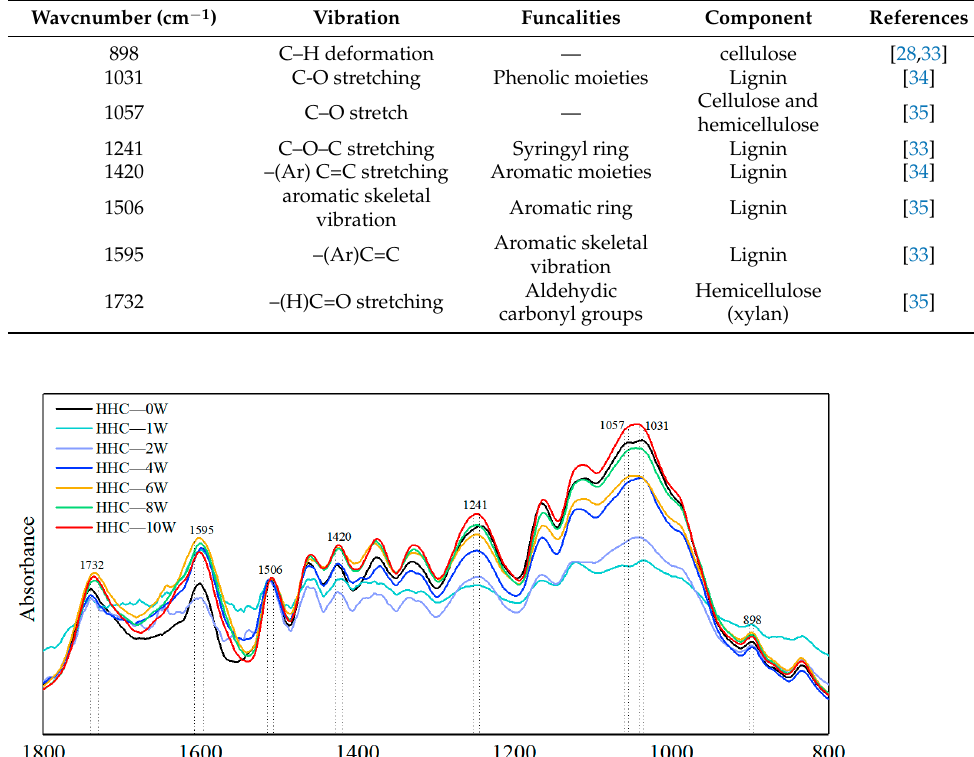
Table 5. Assignment of significant functionalities from FTIR spectra.